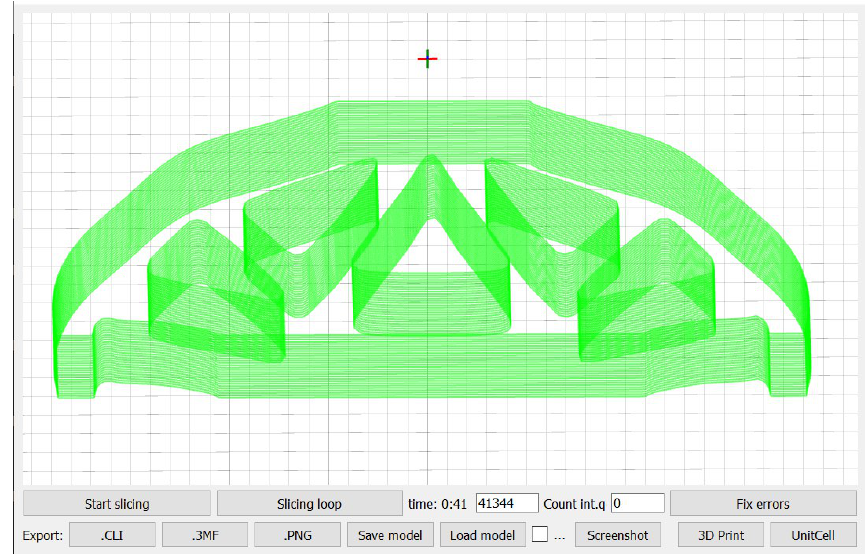
Figure 4. Visualization of an FRep model layer by layer.